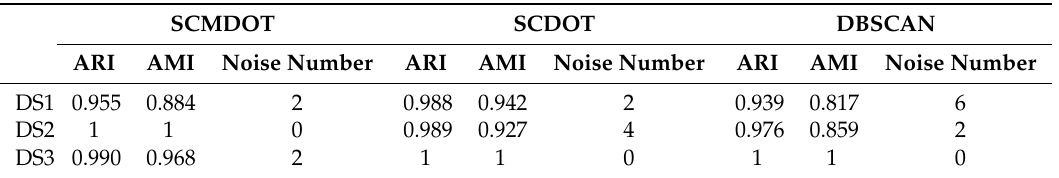
Table 2. Results in Adjust Rand index (ARI) and Adjusted Mutual Information (AMI) for DS1, DS2, and DS3 datasets.